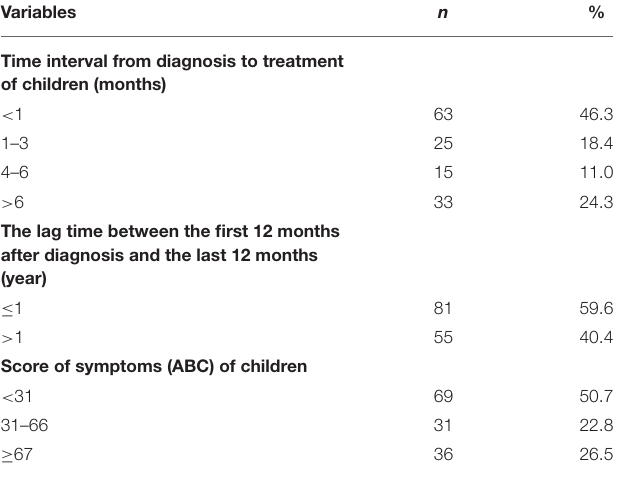
TABLE 1 | General information of participants and disorder characteristics of